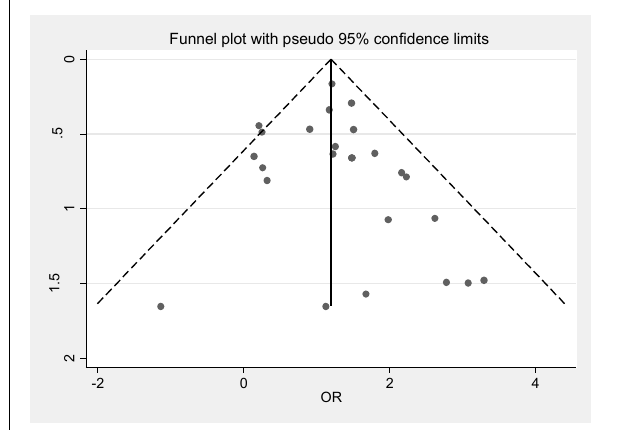
FIGURE 7 | Publication bias (odds ratio of male infertility due to exposure to different bacteria based on the funnel